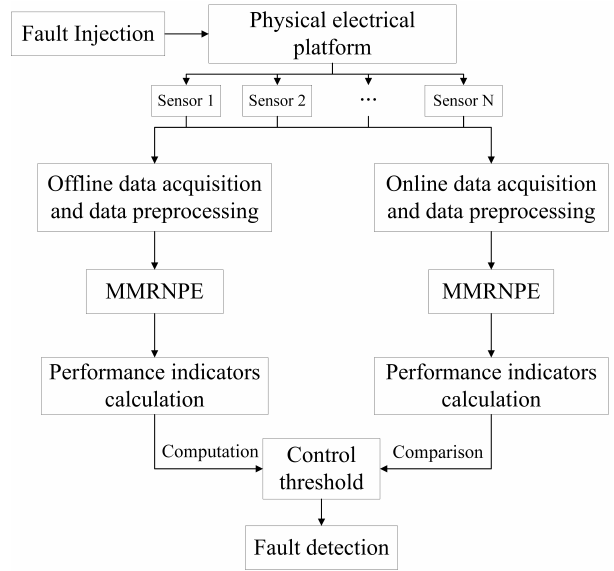
Figure 2. Construction of data-based information fusion